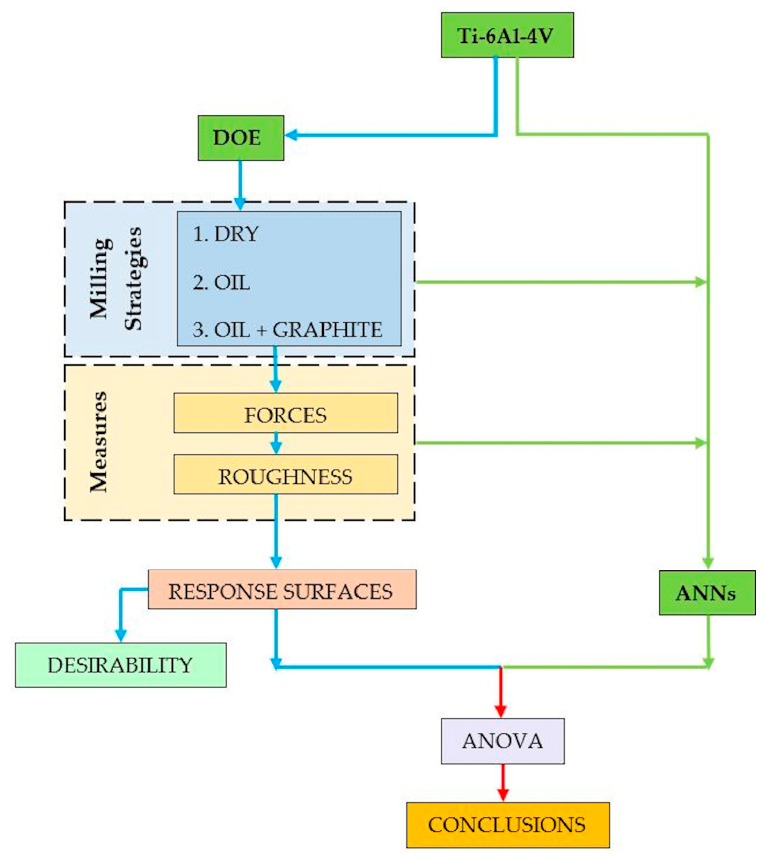
Figure 1. Experiment overview.